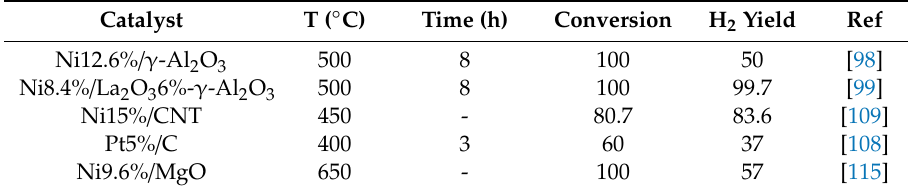
Table 2. Glycerol steam reforming, conversion, and H 2 yield using the most promising metal-supported catalysts.